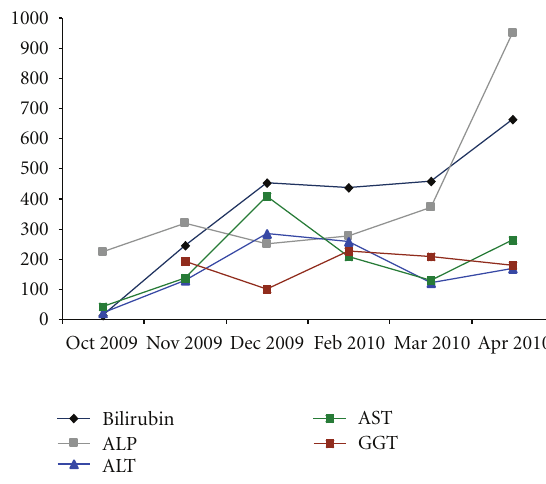
Figure 1: Serial liver tests for patient Mr. X. Bilirubin (Normal: 3–24 umol/L), ALP: Alkaline phosphatase (Normal: 32–103 U/L), ALT: alanine transaminase (Normal: 7–36 U/L), AST: aspartate transaminase (Normal: 15–33 U/L), GGT: γ -glutamyl transferase (Normal: 11–63